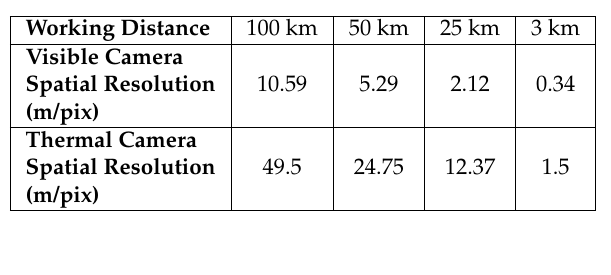
Table 2. Spatial resolution comparison between the two payloads at various spacecraft working